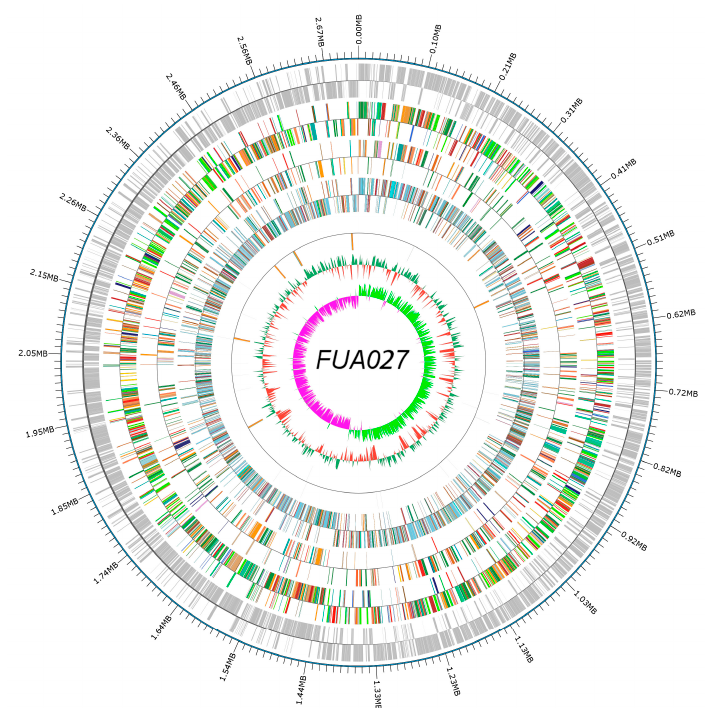
Figure 1. Whole genome map. The outermost circle is the genome sequence position coordinates, and from outside to center are the coding gene, gene function annotation results (COG, KEGG, GO database annotation results information), ncRNA, and genome GC content: the inward red part indicates that the GC content of the region is lower than the average GC content of the whole genome, and the outward green part is the opposite; and genomic GC skew value: the inward pink part indicates that the GC content of G in the region is lower than that of C; the outward light green part is the opposite. Table 1. Characteristics of the E. faecium FUA027 genome.